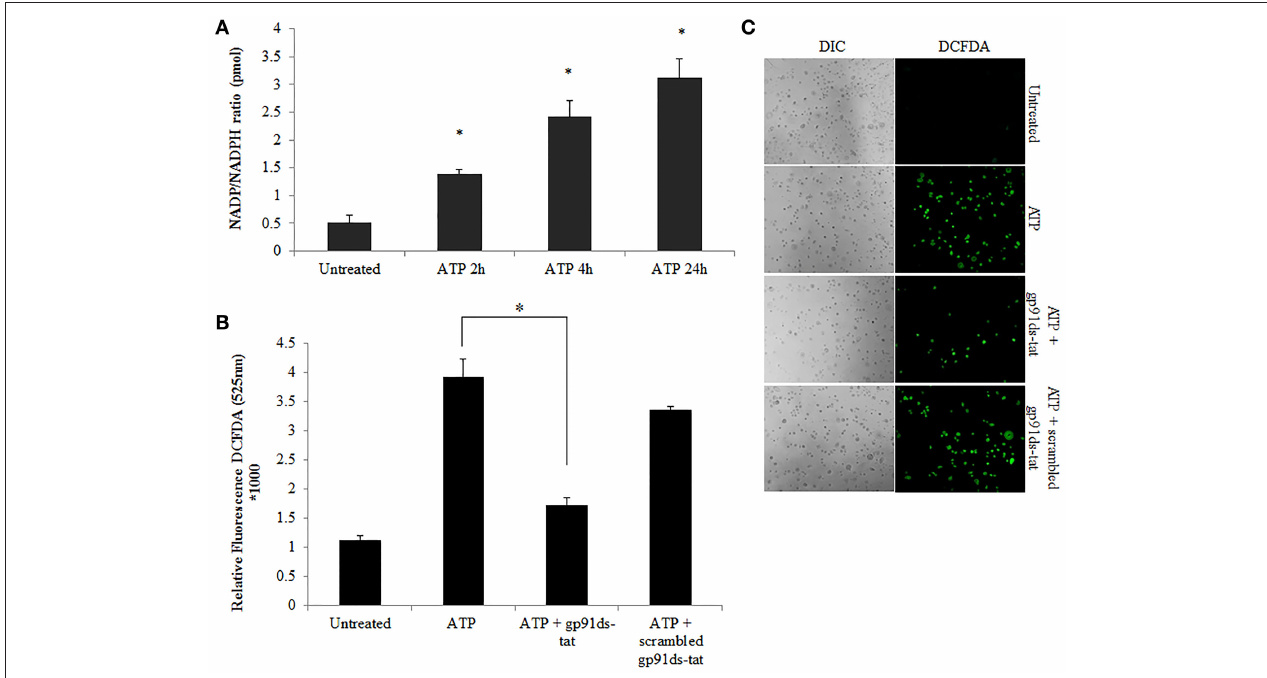
FIGURE 3 | NOX2 is a major contributor to ATP-induced ROS in GECs. (A) Measure of NADP/NADPH ratio in ATP (3 mM) treated primary GEC lysates at 2, 4, and 24h. Increased NADP/NADPH ratio corresponds to more consumed NADPH. N = 3, * p < 0.05 as compared to untreated. (B) ROS generation in primary GECs after 30 min pre-treatment with ATP (3 mM) and incubation for 2 h with gp91ds-tat peptide (50 µ M) (inhibitor of NOX2), or gp91ds-tat scrambled peptide (50 µ M) (non-targeting peptide) measured as relative fluorescence using a Biotek H1M monochromatic plate reader at 525 nm. Delivery of gp91ds-tat into primary GECs was confirmed using (50 µ M) FAM-labeled peptide (not shown). N = 3, * p < 0.05 decrease as compared to ATP. (C) Representative micrographs of CM-H 2 DCFDA, ROS probe, live fluorescence imaging combined with Differential Interference Contrast (DIC) microscopy was used for qualitative assessment of the ROS generation with ATP (3 mM) treatment and NOX2 inhibitor peptides shown quantitatively in (B) . DIC shows the number of cells for relative comparison. 10x magnification on Leica inverted